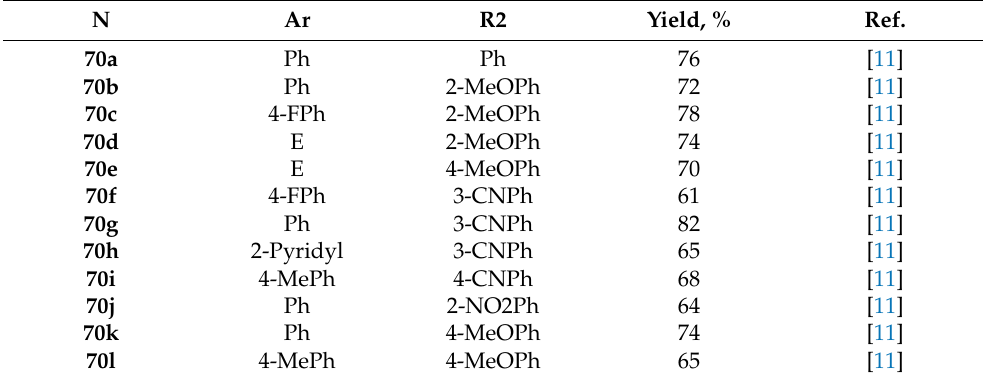
Table 17. Substituents and yields of reaction of imidazopyrimidines and diarylacetylenes (Scheme 35). N N Ar R2 Yield, %